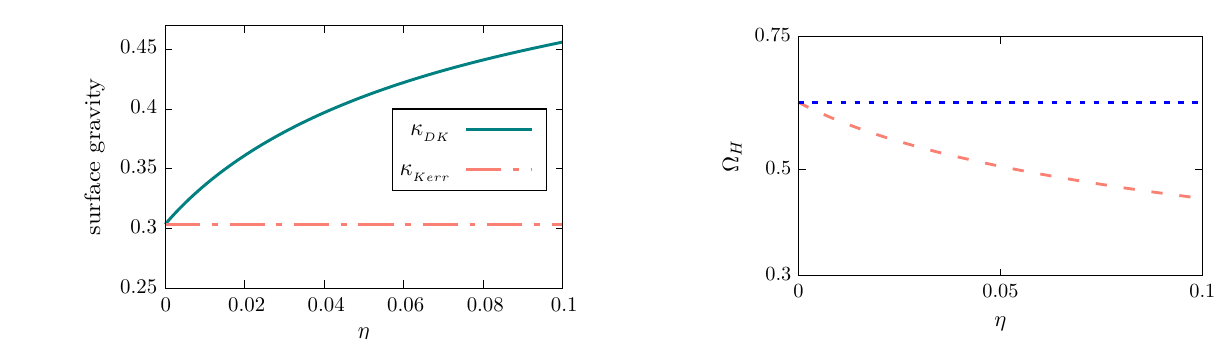
Fig. 4 In the above figure the event horizon’s surface gravity κ deformed BH spacetime, denoted by κ We have set the other parameters at a = 0 . 45, r s = 1. The plot also depicts the case when η = 0, i.e., the Kerr BH scenario, denoted by κ